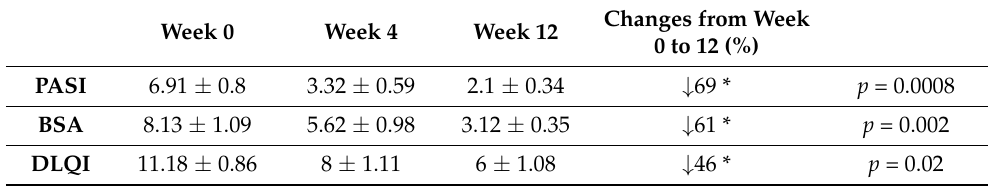
Table 2. Disease activity measured by PASI, BSA and DLQI scales in patients ( n = 10) treated with cal- cipotriol/betamethasone dipropionate foam during week 0, 4 and 12. Asterisks show the statistically significant differences between week 0 and week 12. ↓ —means decrease, ↑ —means